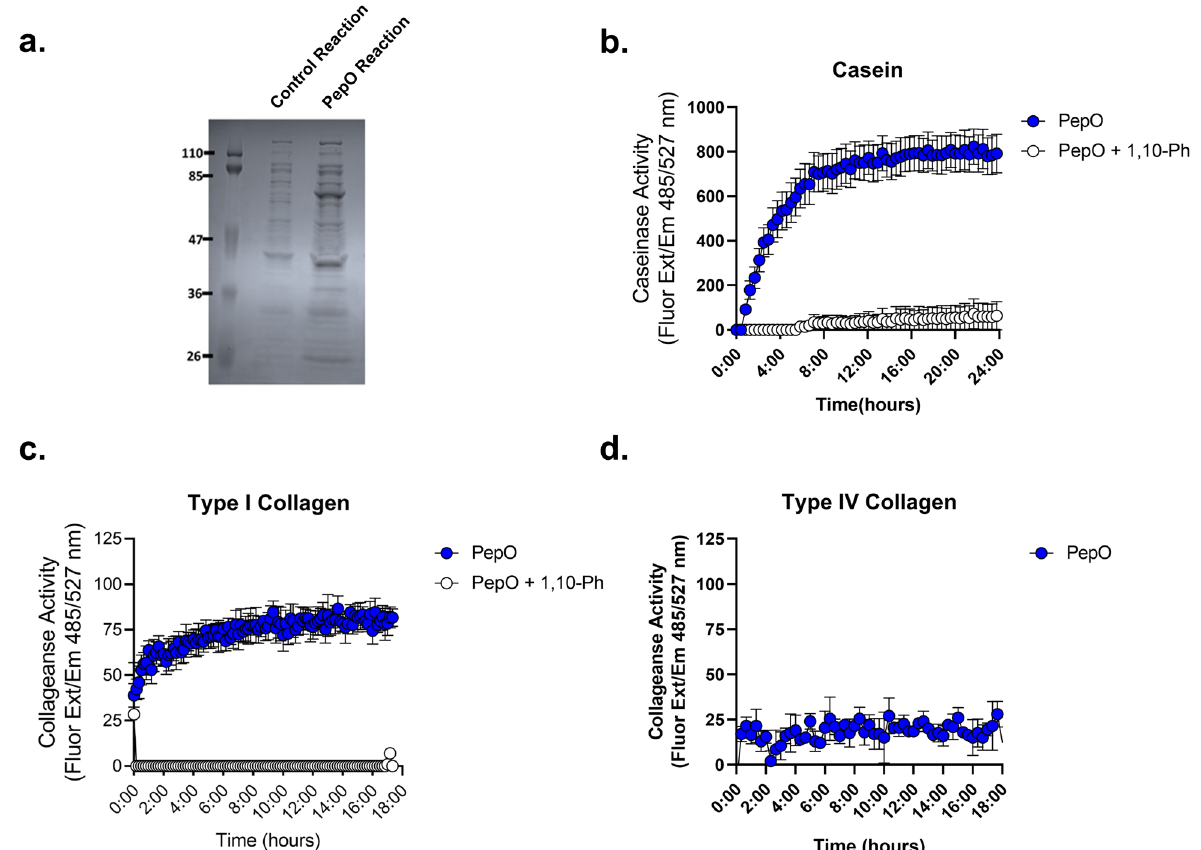
Fig. 7 The P. asaccharolytica metalloprotease PepO degrades casein and type I collagen. a SDS-PAGE of control in vitro transcription/ translation (myTXTL ® ) reaction (RNA polymerase only) and PepO myTXTL ® reaction. b – d PepO myTXTL ® reactions were incubated with b fl uorescein (FITC)-casein or c fl uorophore-conjugated type I collagen in the presence of 0.5 mM 1,10-phenanthroline. Casein degradation was measured by detecting the increase in fl uorescence over a 24-h time course. Results are presented as mean ± standard error from three independent experiments. Collagen degradation was measured by detecting the increase in fl uorescence over an 18-h time course. Results are presented as mean ± standard error from fi ve independent experiments. d PepO myTXTL ® reactions were incubated with fl uorophore- conjugated type IV collagen over an 18-h time course and results are presented as mean ± standard deviation from one independent experiment. The mean fl uorescence readings of the negative control were subtracted from experimental wells and relative fl uorescence units (RFU) was plotted over time, with negative values adjusted to